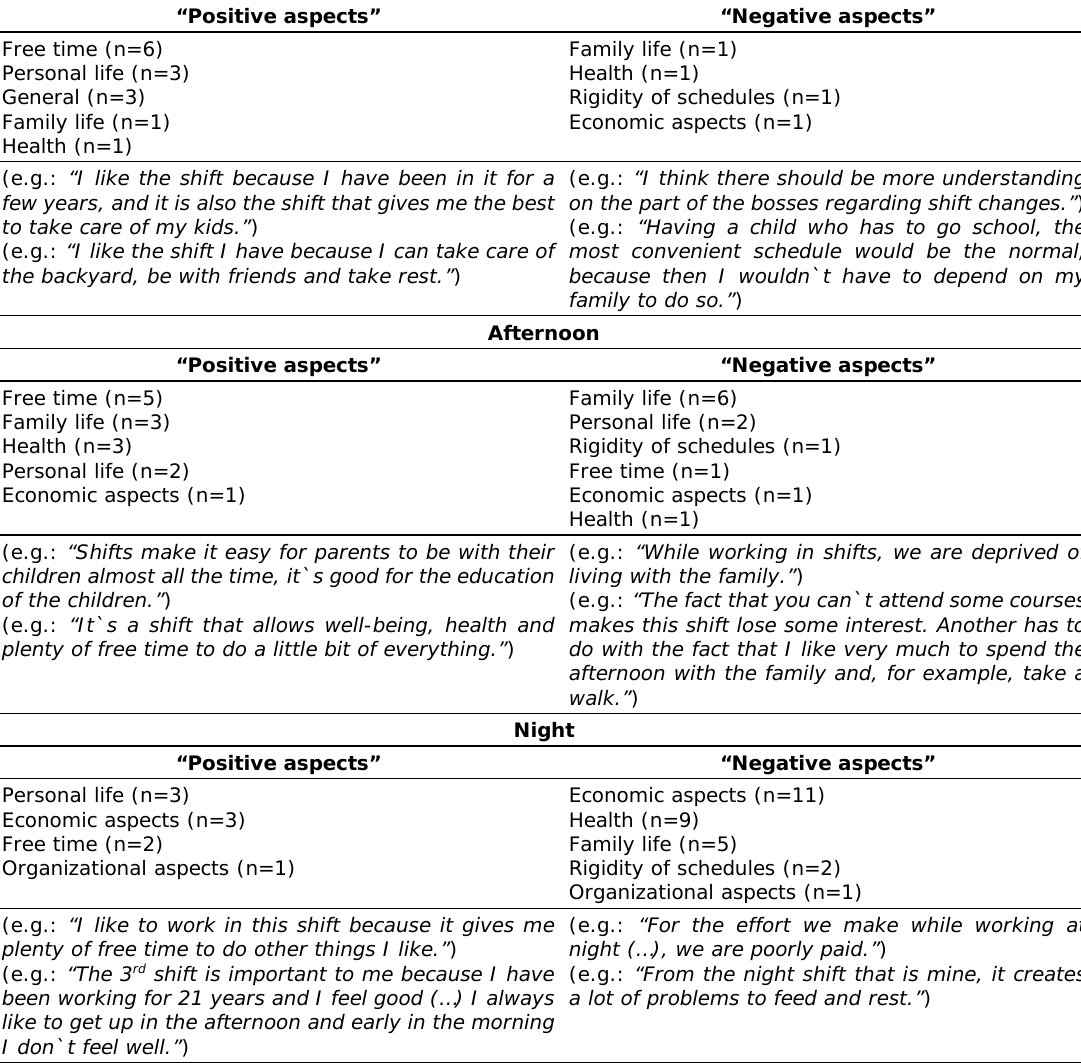
Morning Family life (n=1) Health (n=1) Rigidity of schedules (n=1) Economic aspects (n=1)